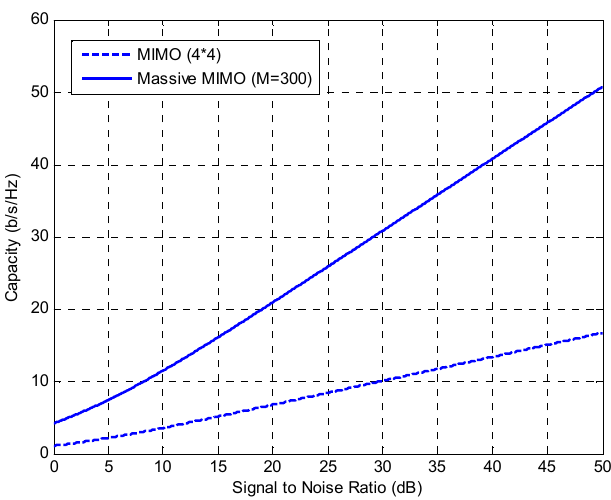
Figure 11. Comparison between Conventional MIMO and Massive MIMO Systems in term of Capacity.